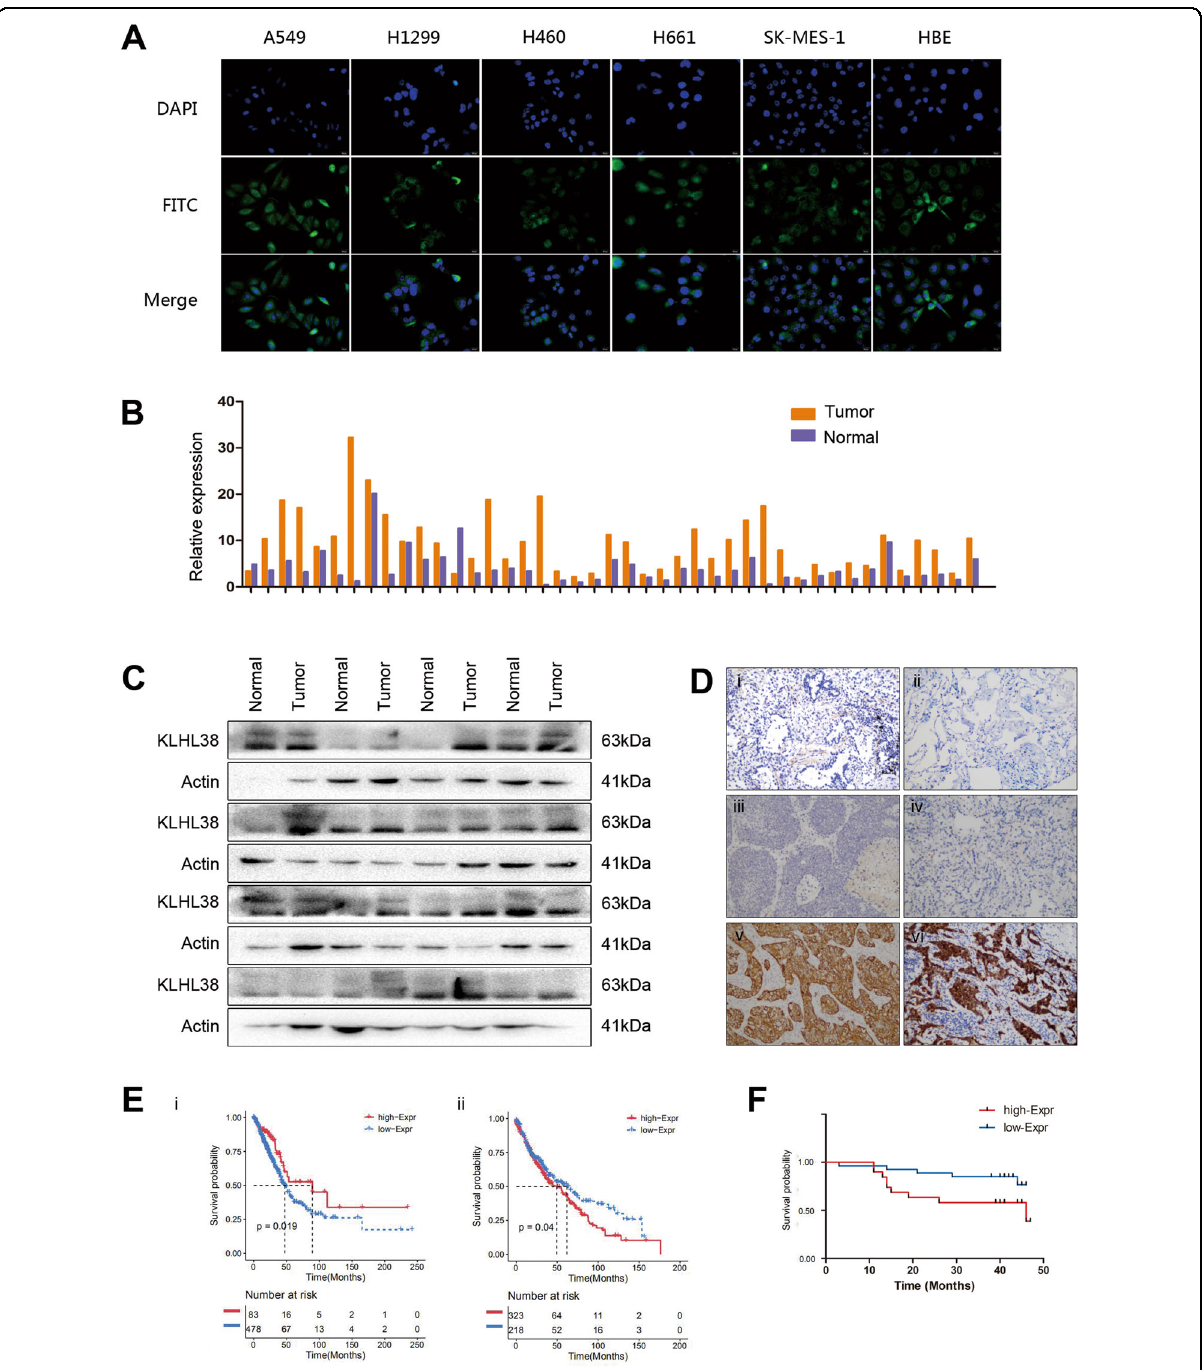
Fig. 1 Expression of KLHL38 in non-small cell lung cancer (NSCLC) cells is associated with poor clinical prognosis. A Immuno fl uorescence was performed to detect KLHL38 localization in NSCLC cell lines and human normal bronchial epithelial cells. B Relative expression of KLHL38 in 43 paired NSCLC samples (orange bars) and paracancerous lung tissue (purple bars). C KLHL38 levels in 14 lung cancer tissues and matched normal tissues. D KLHL38 levels in alveolar (i) and normal bronchial epithelial cells (ii), well-differentiated squamous cell carcinoma (iii) and adenocarcinoma (iv), and poorly differentiated squamous cell carcinoma (v) and adenocarcinoma (vi) using immunohistochemistry. Magni fi cation: ×200. E Survival analysis of NSCLC patients with high and low KLHL38 expression in lung adenocarcinoma (i) and lung squamous cell carcinoma (ii) based on TCGA data. F Survival of NSCLC patients with high and low KLHL38 expression analyzed based on the results of the present